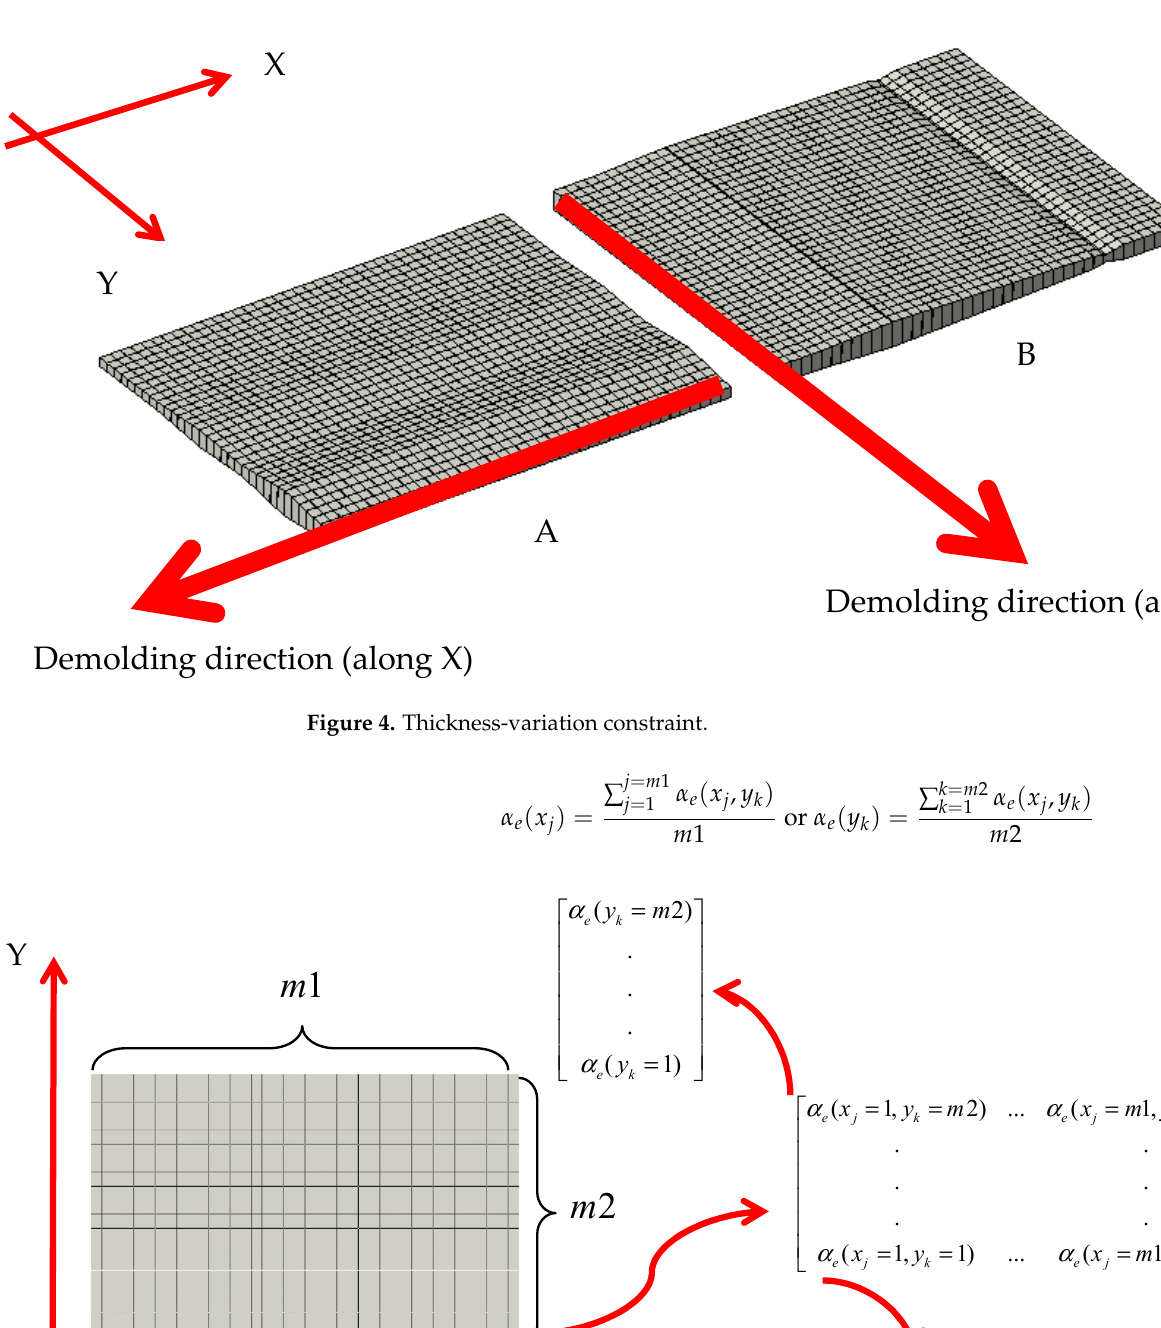
Figure 5. Thickness-sensitivity constraint.